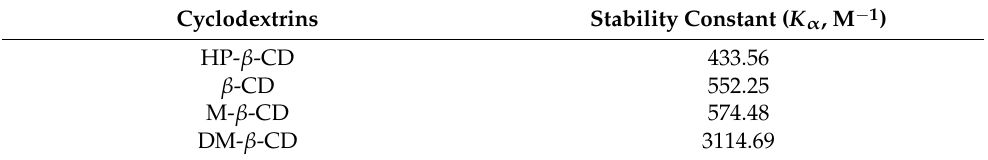
Table 2. Solubilization efficacy of MTX in different CD solution. Each value represents the mean ± SD ( n = 3). Cyclodextrins